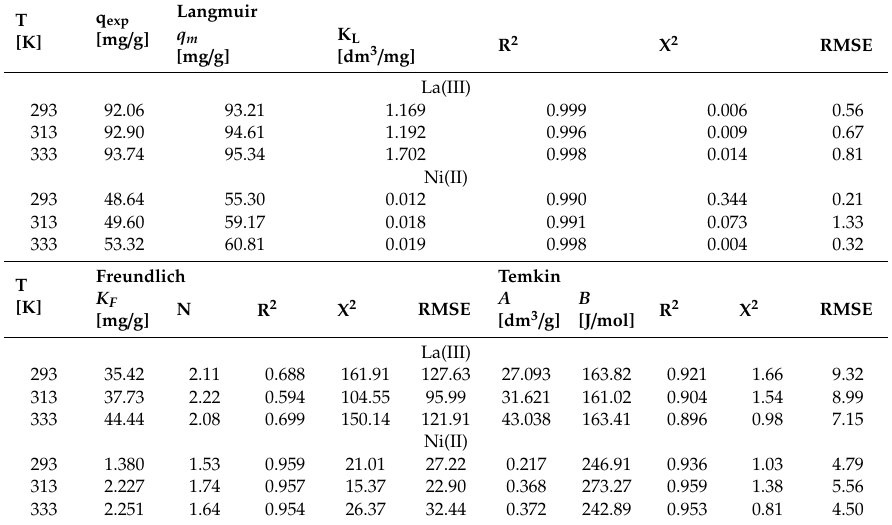
Table 3. Isotherm parameters for the La(III) and Ni(II) ions sorption on LewatitMonoplus SP112.